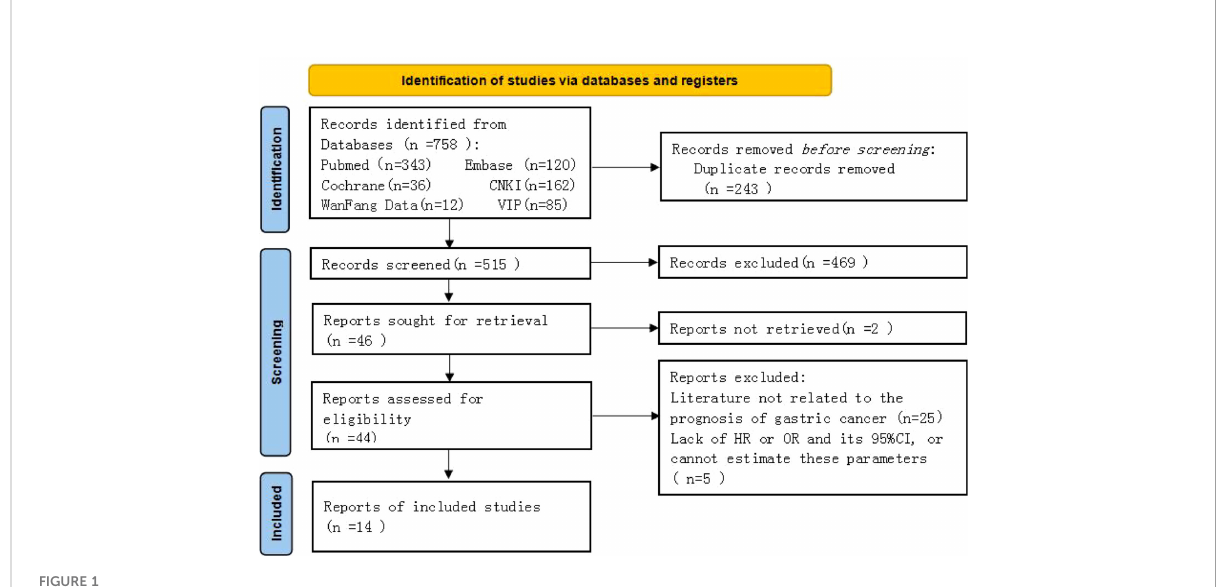
FIGURE 1 Literature screening process and